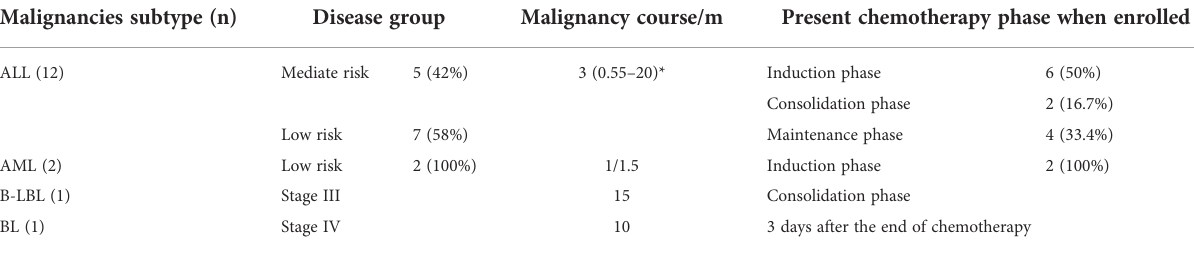
TABLE 2 Chemotherapy information of children with hematological malignancies and